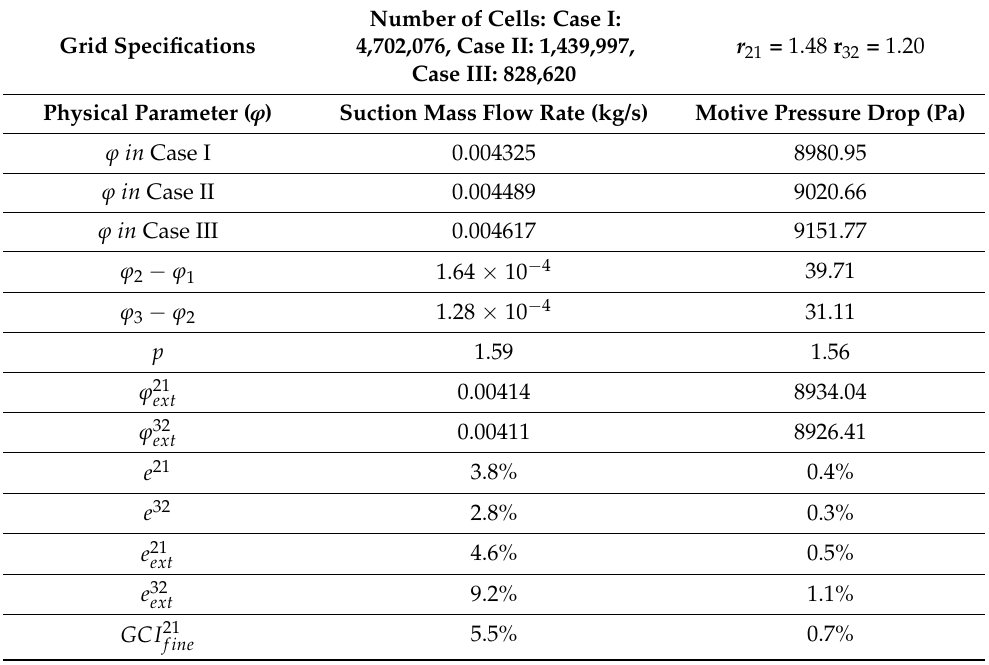
Figure 5. Motive pressure drop (Pa) vs. motive mass flow rate (g/s) for nozzle tests with no suction. See Table 3 for nozzle geometry details. For the T1 geometry, the uncertainty bars are smaller than the experimental marker used.